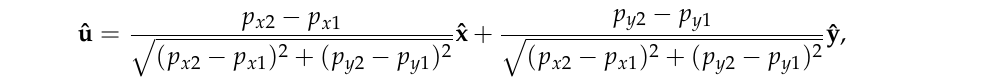
,y i separated by ∆ t t